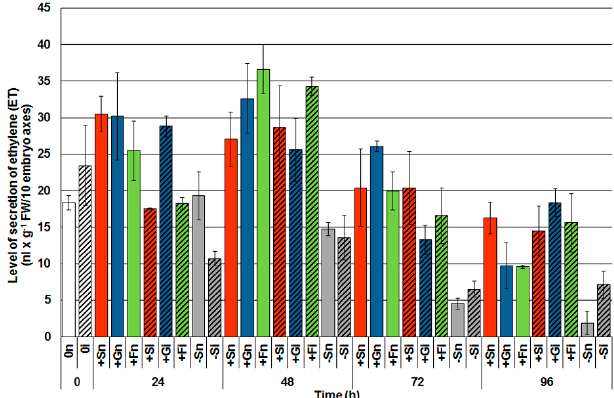
Figure 3. E ff ect of sucrose, glucose and fructose on the secretion of ethylene (ET) in in vitro cultured embryo axes of Lupinus luteus infected with Fusarium oxysporum f. sp. lupini . A summary of the statistical significance of di ff erences between the average values of each pair at p < 0.05 can be found in the Supplementary Files (Table